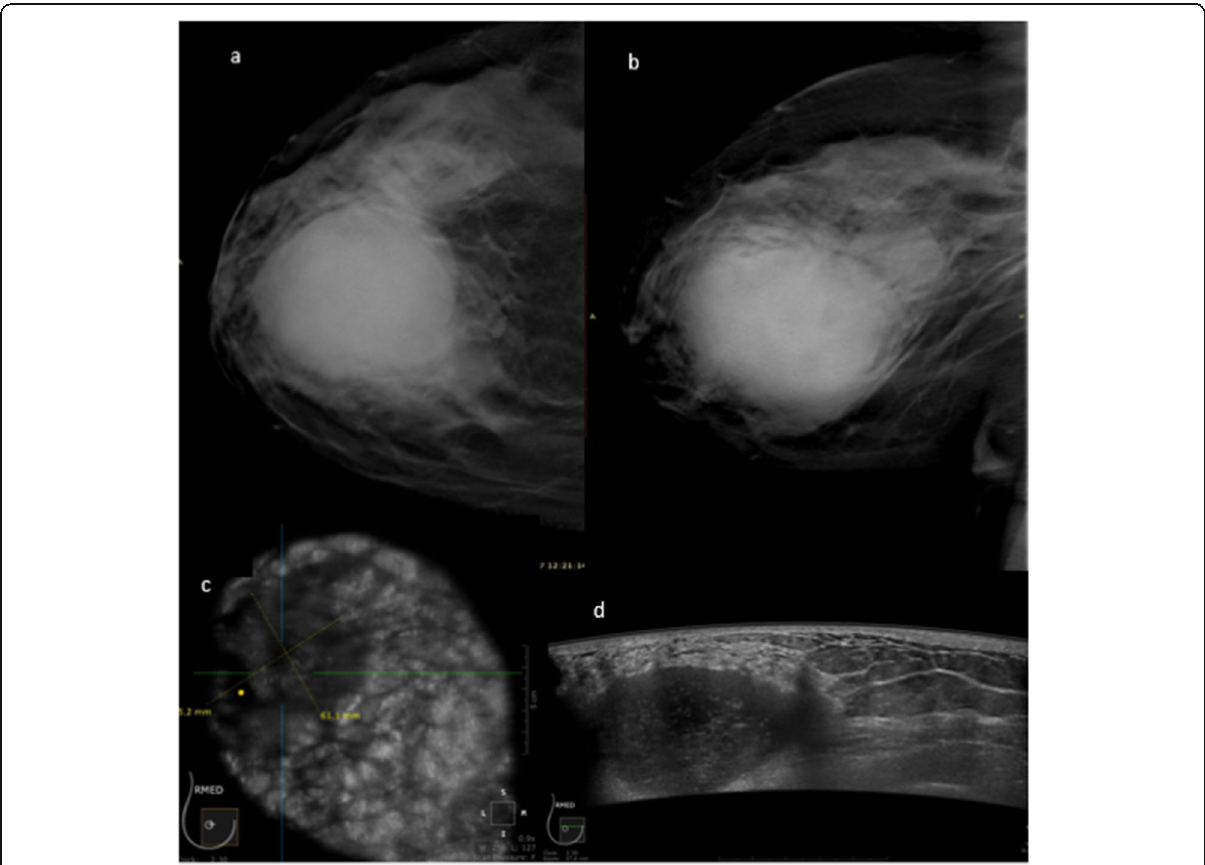
Fig. 2 A 42-year-old female patient was presented with right tender breast. Digital tomosynthesis Mx CC and MLO views of the right breast ( a , b ) show an oval-shaped circumscribed high-density retro areolar mass associated with skin thickening (BIRADS III). c Automated ultrasound right medial coronal image shows a large defect at 2:30 o ’ clock. d Automated ultrasound right medial axial image shows a right oval-shaped mass with indistinct margin, parallel orientation, and hypoechoic echo pattern (BIRADS III). The lesion was proved to be inflammatory mastitis